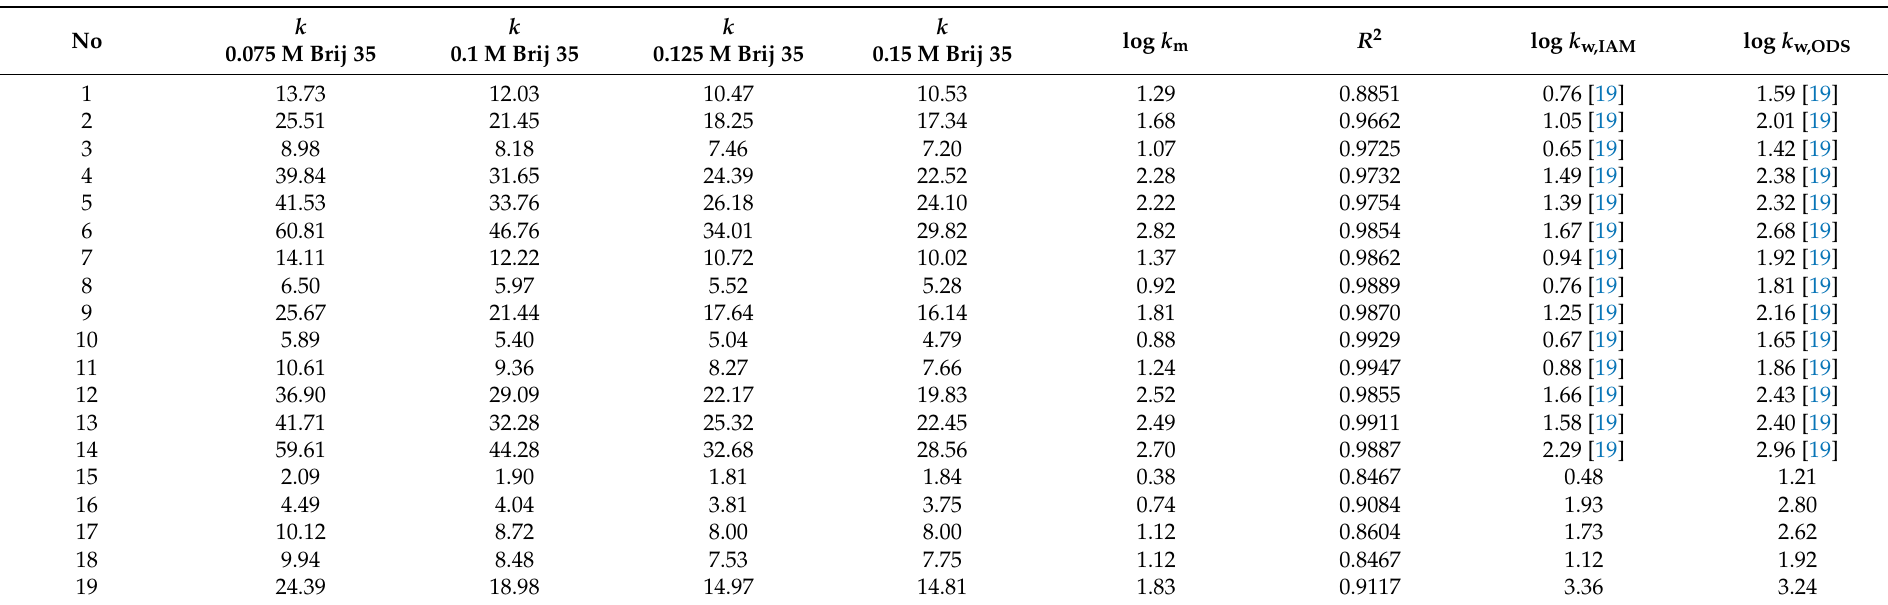
Table 2. Chromatographic data obtained for all the tested compounds from MLC technique ( k , log k m ) with the ODS-2 column and Brij 35 as the effluent component and on IAM